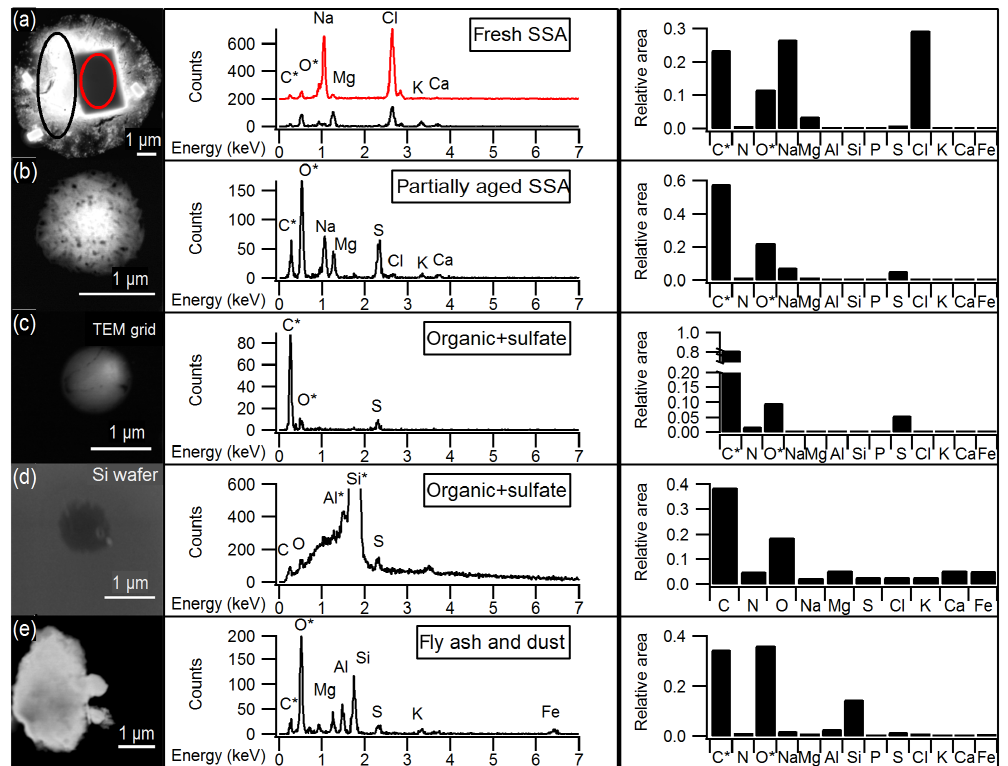
Figure 1. Representative SEM images and EDX spectra of individual particles corresponding to the main particle types observed by CCSEM- EDX, and the average EDX spectrum for each particle type. Average spectra show the relative peak areas of all elements analyzed by CCSEM-EDX. (a) Fresh SSA particle comprised of sodium chloride core (red) and magnesium chloride shell (black). The spectrum for the core is offset for clarity. (b) Partially aged SSA particle containing sodium and more sulfur than chlorine. (c) Organic + sulfate particle. (d) Organic + sulfate particle on silicon substrate. (e) Aluminum- and silicon-containing dust particle. ∗ Carbon and oxygen peaks include some signal from TEM grid substrate background for particles (a) , (b) , (c) , and (e) . Aluminum and silicon peaks are due to sample holder and silicon substrate background, respectively, for particle (d) .